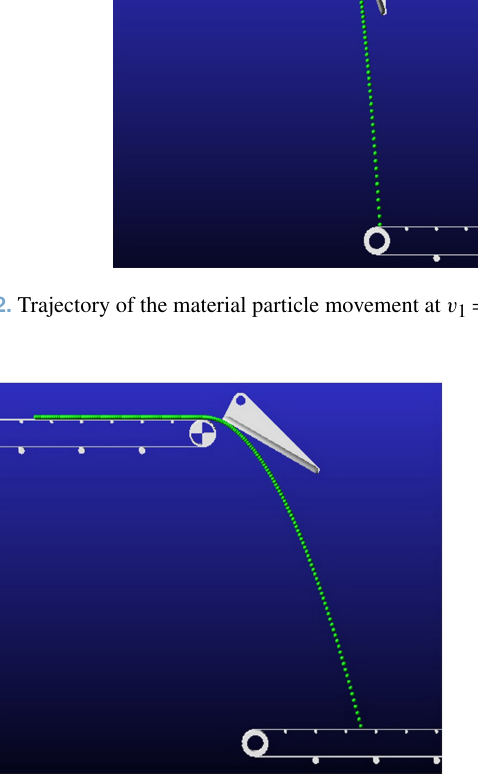
Figure 13. Trajectory of the material particle movement at v 1 ms − 1 , α = 60 ◦